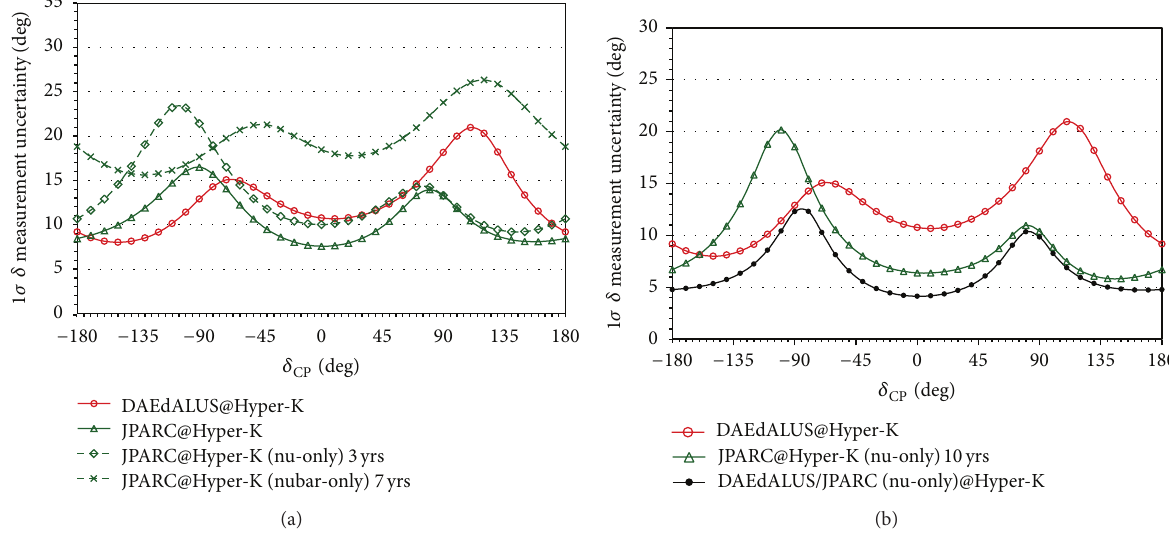
Figure 15: (a) 1 𝜎 measurement sensitivities for the nominal JPARC@Hyper-K run (solid green with triangles) compared to DAE 𝛿 ALUS@Hyper-K (solid red) assuming the normal mass hierarchy. Dashed green curves show contributions of neutrino and antineutrino running to the total sensitivity of JPARC@Hyper-K. (b) DAE 𝛿 ALUS/JPARC(nu only)@Hyper-K combined measurement sensitivity assuming the normal mass hierarchy. The contribution to the combined measurement from DAE 𝛿 ALUS antineutrinos is indicated in red and the contribution from JPARC neutrinos is indicated in green.